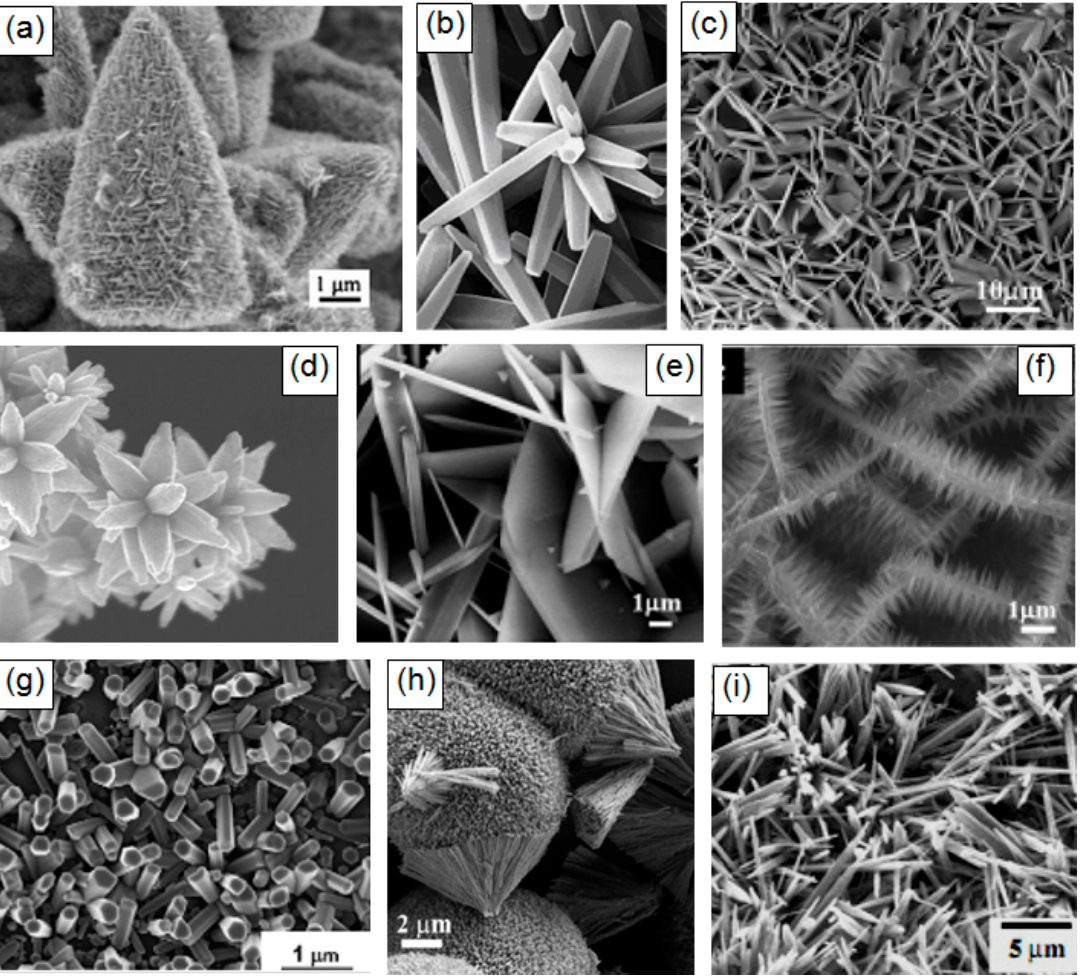
Figure 1. SEM images of ZnO and Cu 2 O nanostructures synthesized by different methods. Figure1. SEMimagesofZnOandCu 2 Onanostructuressynthesizedbydifferentmethods.